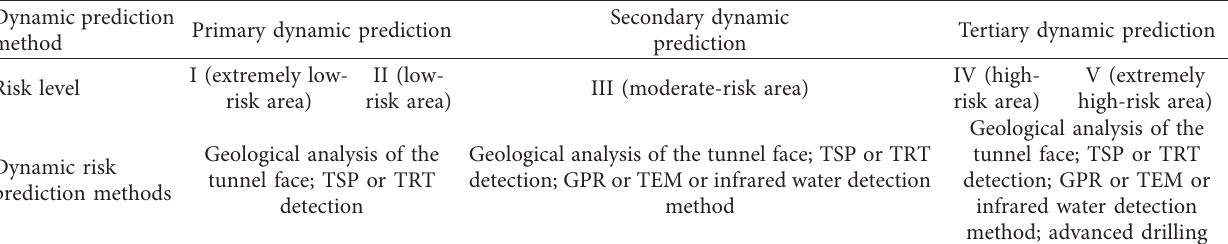
Table 14: Dynamic risk prediction method of water inrush in